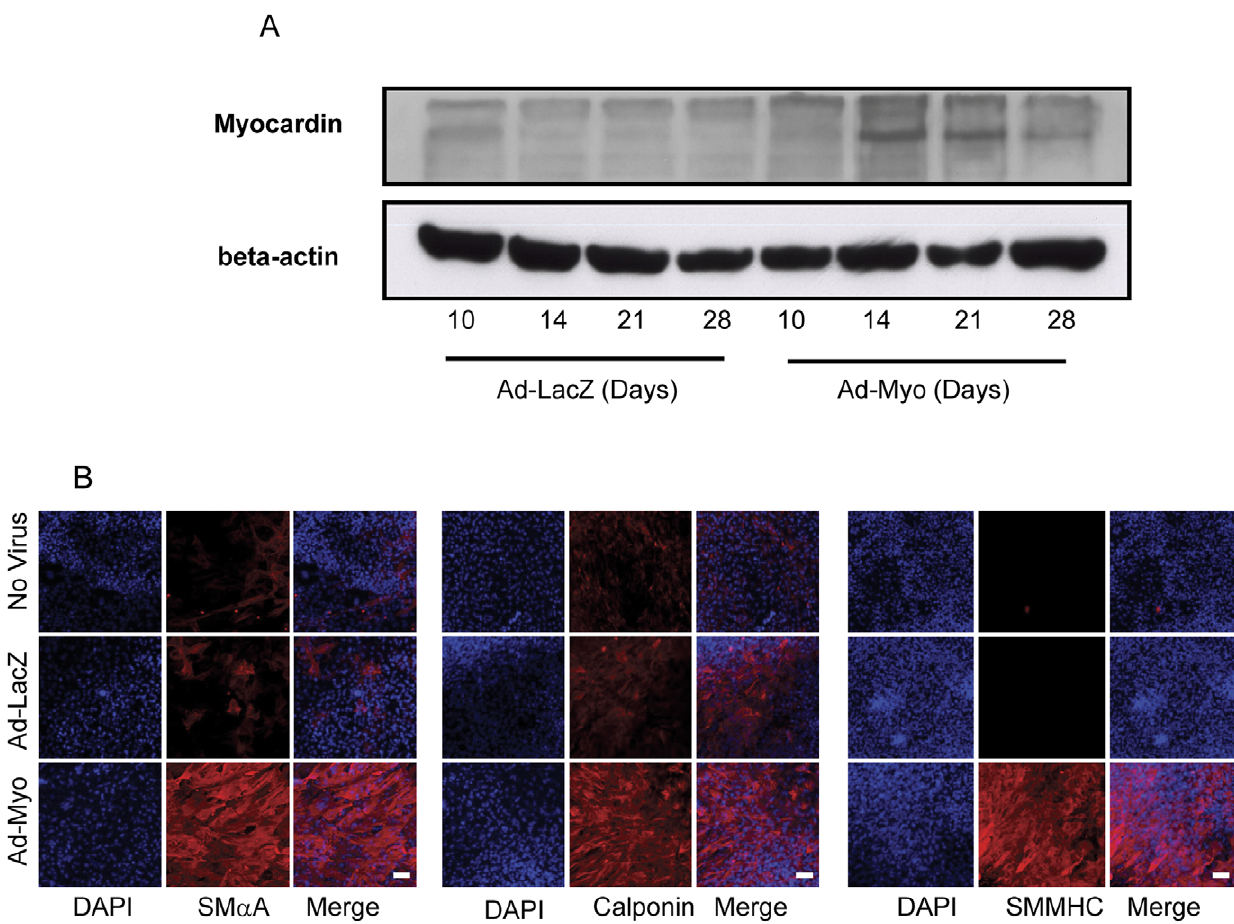
Figure 2. Myocardin overexpression increases SM a A, calponin and SMMHC staining. Immunoblotting of embryoid bodies transduced with Ad-LacZ or Ad-Myo confirm myocardin overexpression at a variety of developmental times (A). Immunofluorescent assessment of day 28 embryoid bodies reveals an increase in SM a A, calponin and SMMHC (B) staining following treatment with Ad-Myo from day 10 onwards, in comparison to no treatment or Ad-LacZ negative controls. Photomicrograph exposure times were kept constant across all three treatment groups and deliberately low enough to clearly show the large increases in fluorescent intensity in the Ad-Myo group. Nuclei counterstained (blue) with DAPI. Bar=100 m